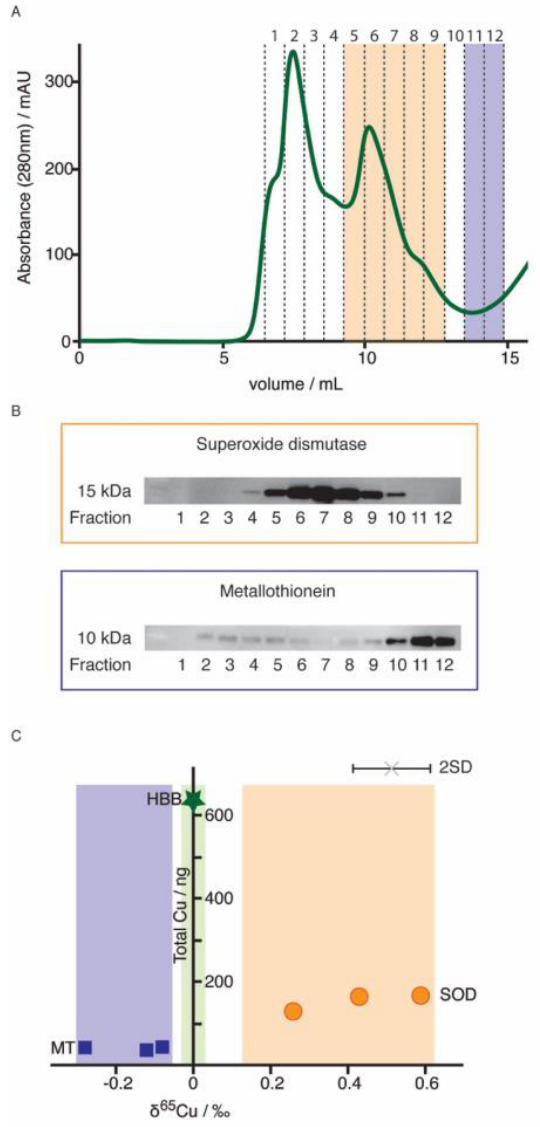
Figure 2. ( A ) Size exclusion chromatography fractionation of soluble human brain homogenate with the collected fraction indicated by dashed lines; elution of proteins was monitored at 280-nm absorbance; ( B ) the collected fractions were subjected to Western blot analysis to determine the fractions containing metallothionein (MT; (cid:4) ) and superoxide dismutase (SOD; (cid:8) ); ( C ) the replicates of the measured Cu isotopic ratio and the total amount of Cu in the MT or SOD fraction are shown relative to bulk brain homogenate (HBB; (cid:70) ). Superoxide dismutase contains copper isotopically heavier than bulk brain and metallothionein.